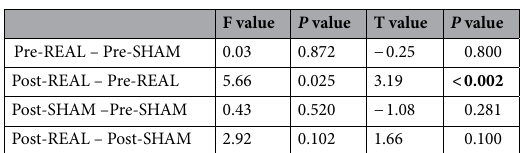
Table 3. Left prefrontal cortex evoked HP fMRI